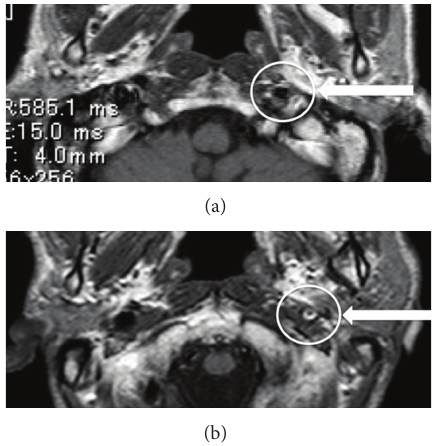
Figure 3: MR imaging (T2). (a) A flow void at the left carotid artery was observed immediately after radiotherapy. (b) No flow void was seen 1.5 years after radiotherapy, suggesting occlusion of the carotid